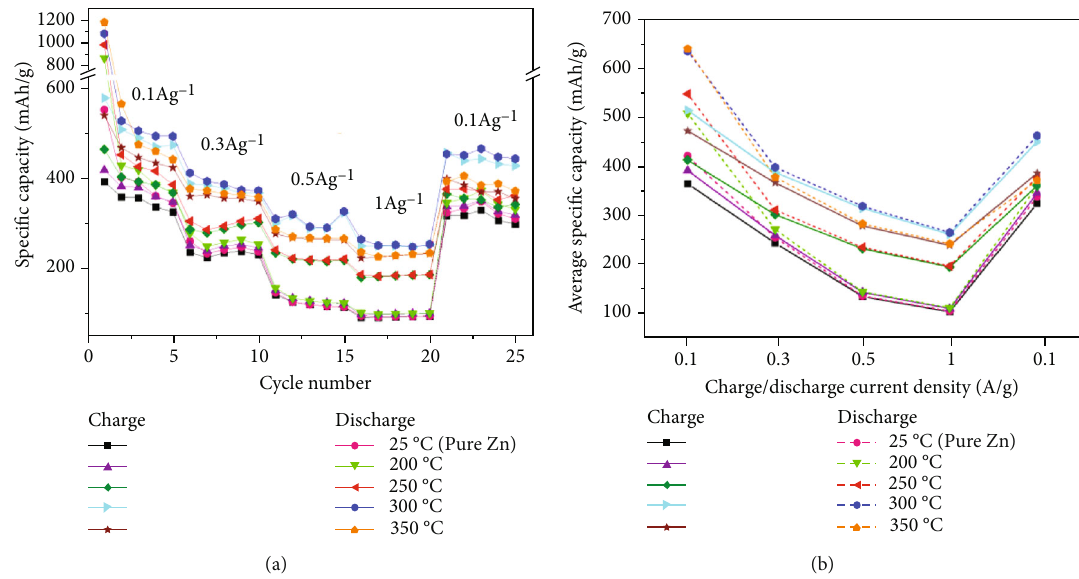
Figure 4: (a) Rate capability and (b) the average speci fi c capacity of the ZnS materials vulcanized at various